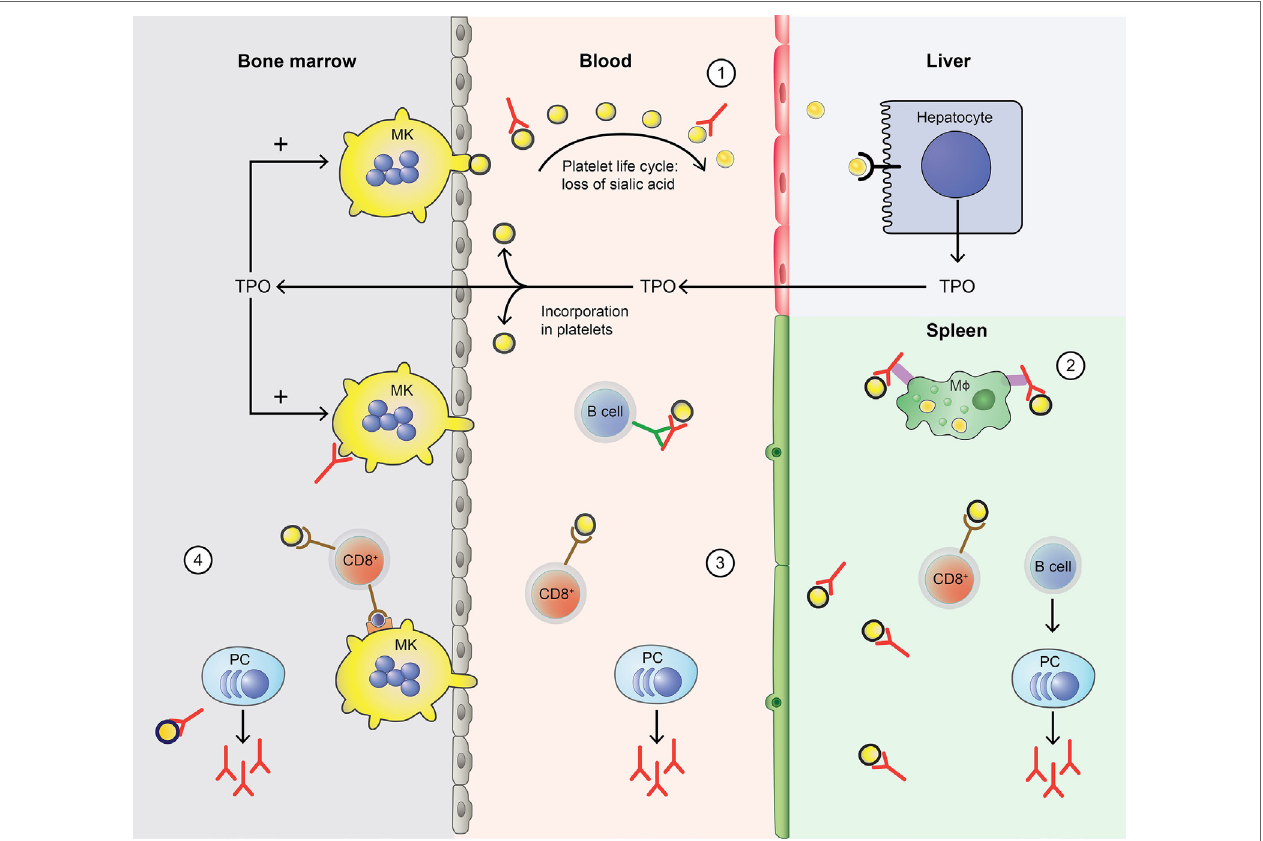
FiGURe 1 | Disturbance of the platelet life cycle in immune thrombocytopenia (ITP). (1) Platelets (yellow) are normally produced by megakaryocytes (MKs, yellow) in the bone marrow. Aging platelets undergo apoptosis but also gradually lose terminal sialic acid from the surface (indicated by black circles). This allows for their clearance in the liver. Liver-mediated platelet clearance triggers hepatic TPO transcription and translation, and new TPO is released. This process is disrupted by autoantibodies in ITP, which are hypothesized to enhance platelet desialylation leading to enhanced clearance. (2) Macrophages (MF, green) can phagocytose platelets; meanwhile, platelet antigens are presented in the spleen to immune cells, such as CD4 + T helper (Th) cells. With CD4 + T cell help, B cells (B cell, dark blue) are able to differentiate into platelet-reactive plasma cells (PC, light blue) that can secrete autoantibodies (red). Cytotoxic T cells (Tc) (CD8 + , red) can directly lyse platelets. (3) In peripheral blood, plasma cells and cytotoxic Tc further induce autoimmune responses against platelets. Cytotoxic Tc may also induce desialylation leading to enhanced clearance. In addition, platelet-reactive memory B cells may be present in the blood. (4) Plasma cells and cytotoxic Tc are also present in the bone marrow, where they can inhibit platelet production by targeting